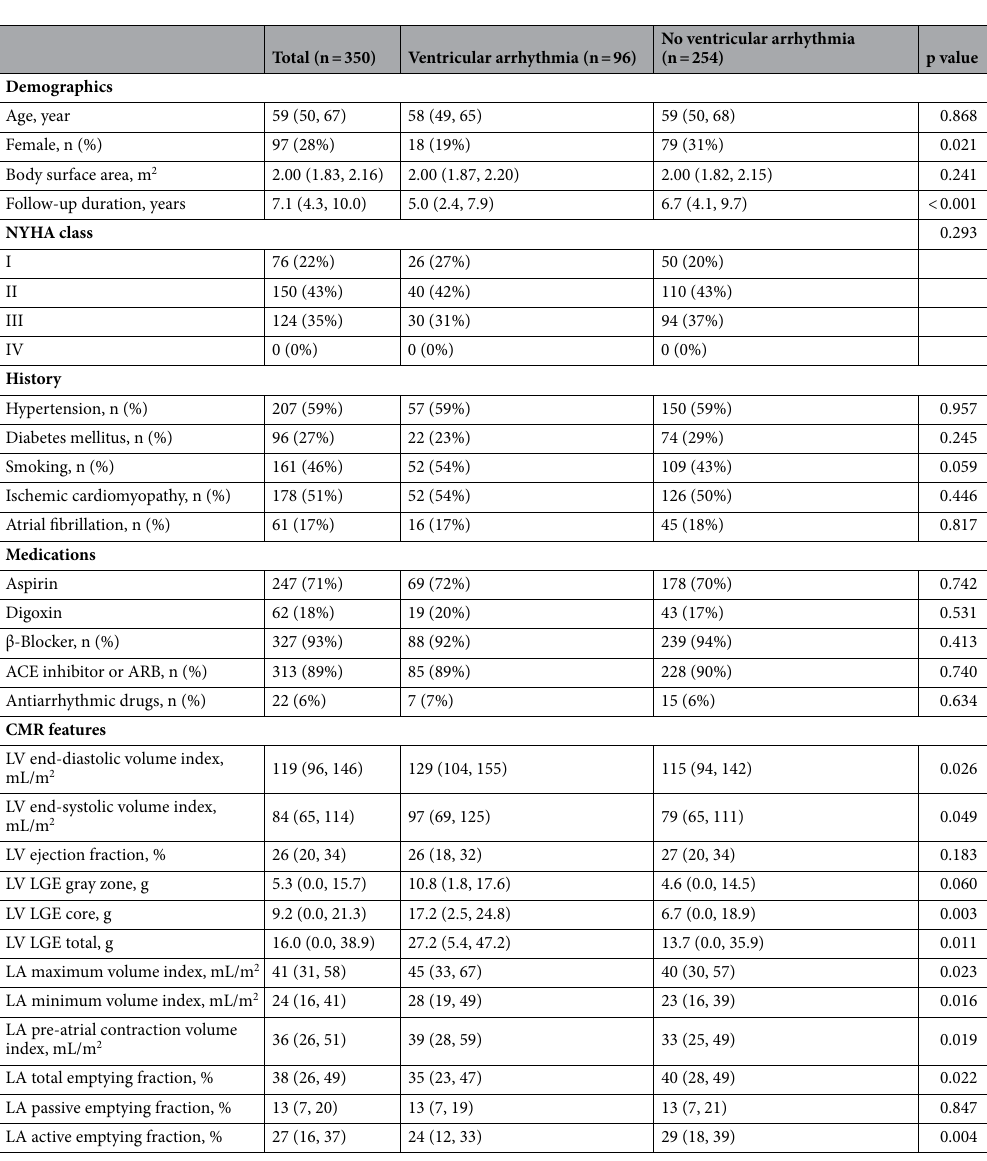
Table 2. Baseline characteristics. Data are median (quartile 1, quartile 3) or n (%). NYHA New York Heart Association, ACE angiotensin-converting enzyme, ARB angiotensin receptor blockers, CMR cardiac magnetic resonance, LV left ventricular, LGE late gadolinium enhancement, LA left atrial.